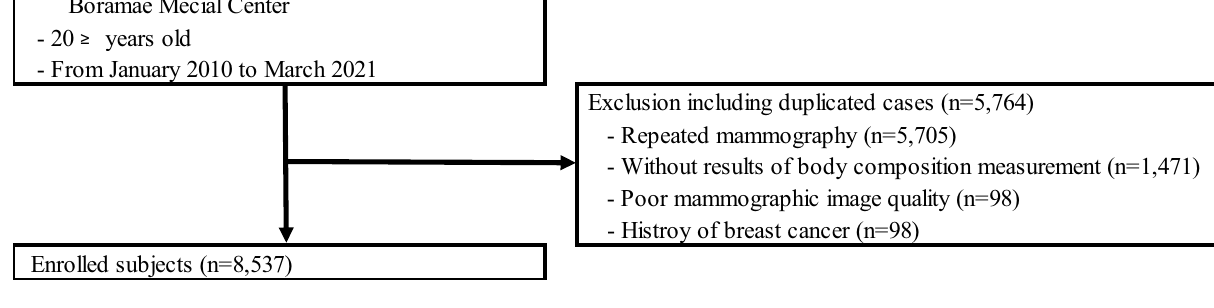
Figure 1. Enrollment flow chart of